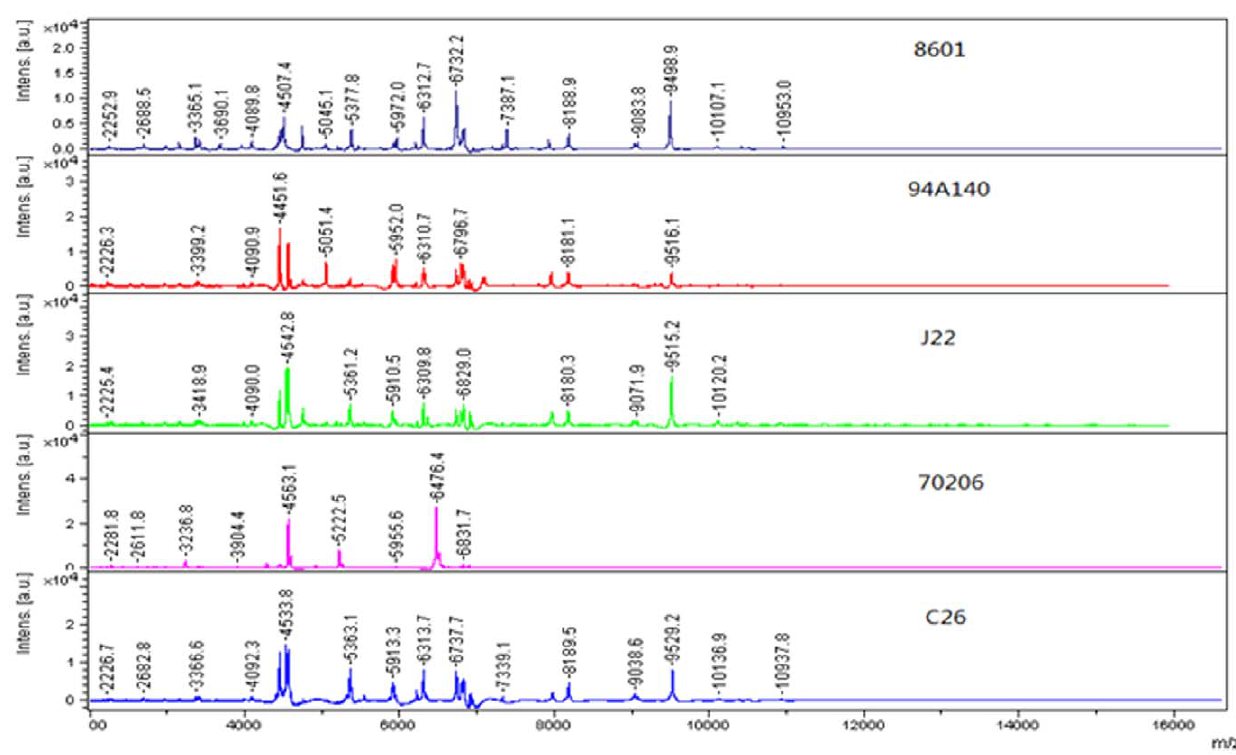
Figure 4. Peptide spectrum of wrongly identified GAS isolates. Isolates 8601, 94A140, J22, and 70206 were wrongly identified by MALDI-TOF MS. Isolate C26 was the positive control. No significant difference was observed between 8601, 94A140, J22 and C26. However, the peaks presented in the spectra of 70206 were obviously different from others.